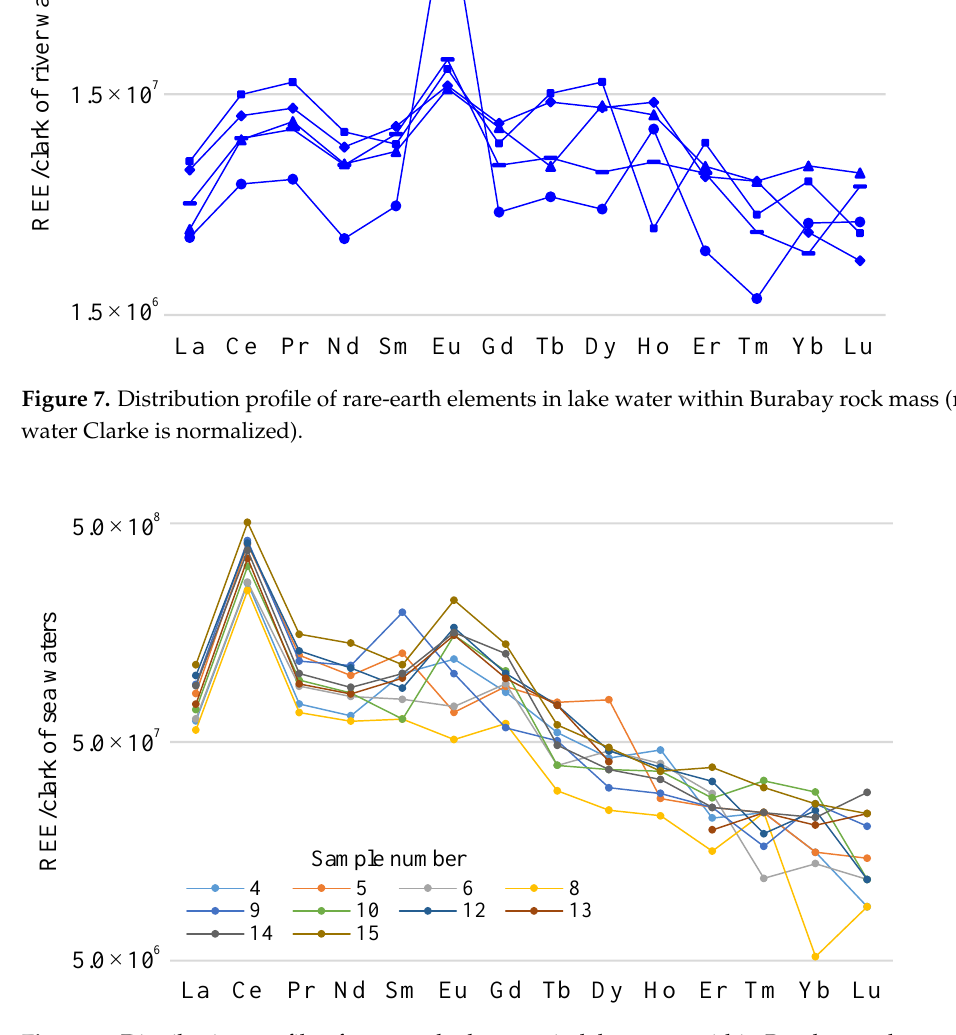
Figure 8. Distribution profile of rare-earth elements in lake water within Burabay rock mass (sea water Clarke is normalized). Table 7. Results of study of the composition of lake water and bottom deposits in Burabay rock mass, depending upon the content of commercial microelements